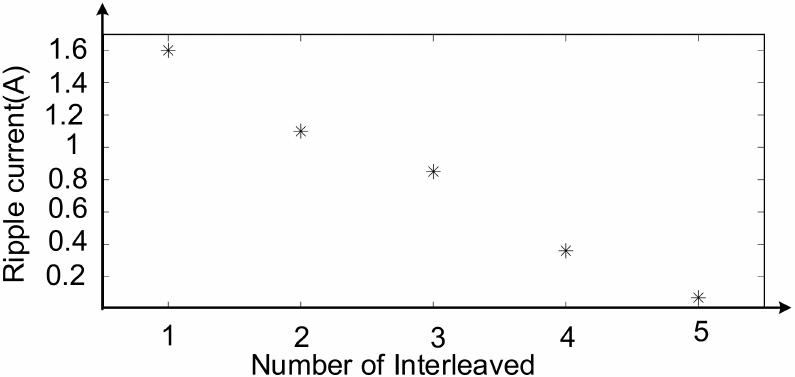
Figure 6. Input ripple current on the basis of the number of the interleaved converters with f sw = 37.5 kHz, P 0 = 1 kW, and L boost =1 mH based on PLECS